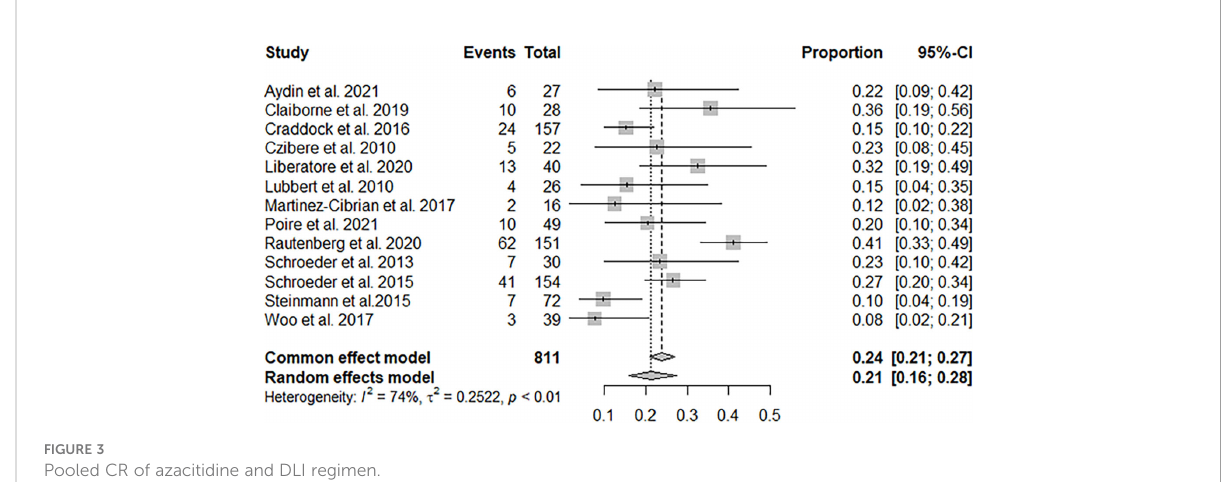
FIGURE 3 Pooled CR of azacitidine and DLI regimen.